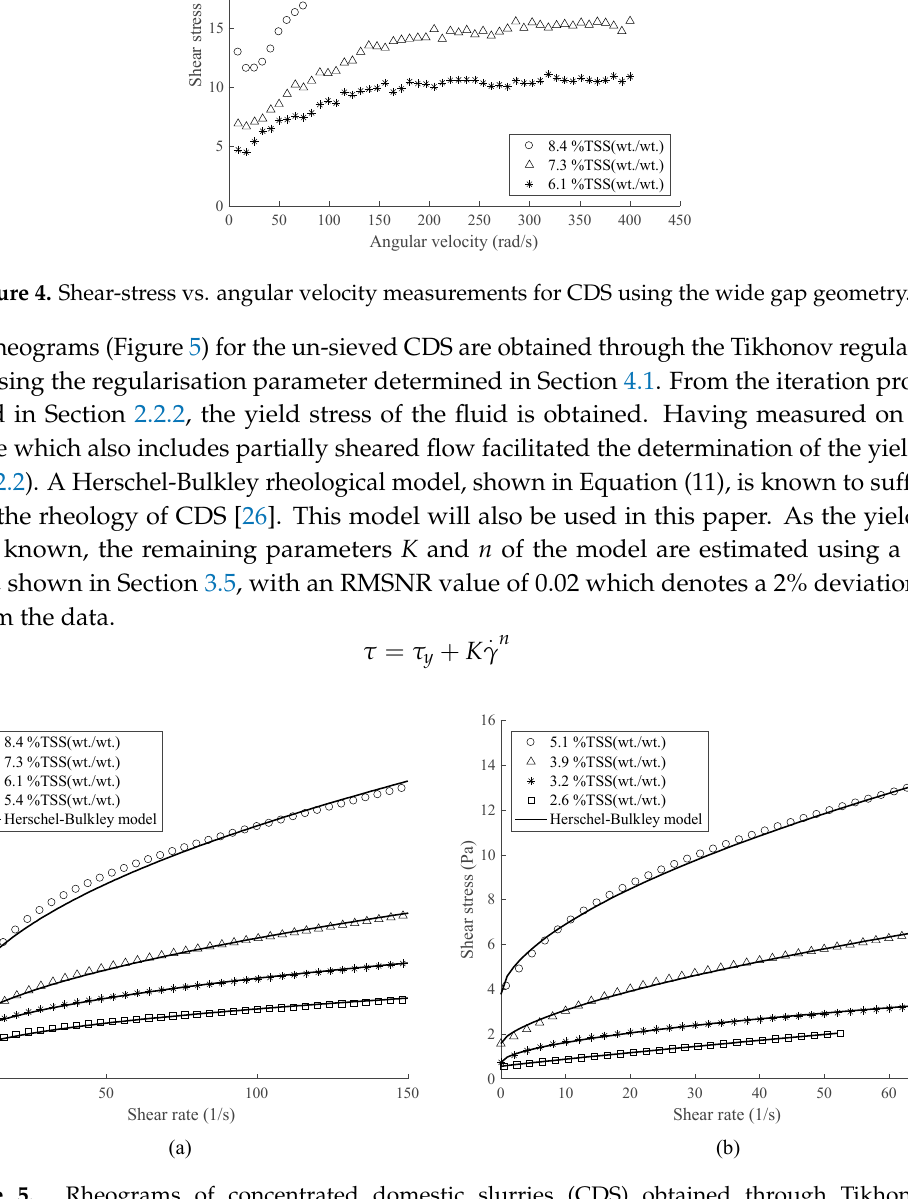
Figure 5. Rheograms of concentrated domestic slurries (CDS) obtained through Tikhonov regularization ( a ) Rheograms of concentration 5.4, 6.1, 7.3 and 8.4% TSS (wt./wt.) ( b ) Rheograms of concentration 2.6, 3.9, 3.2 and 5.1% TSS (wt./wt.).